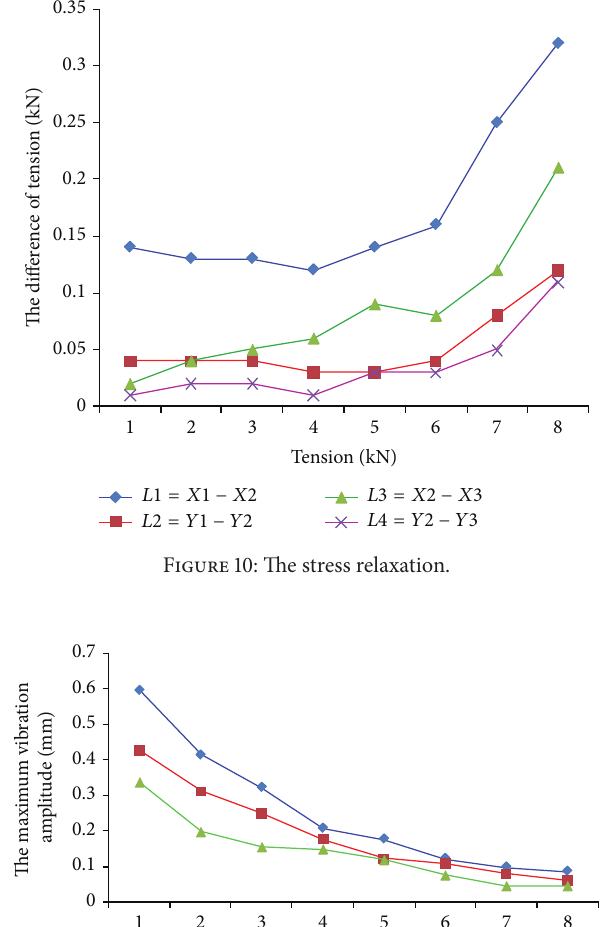
Figure 11: The maximum vibration amplitude.